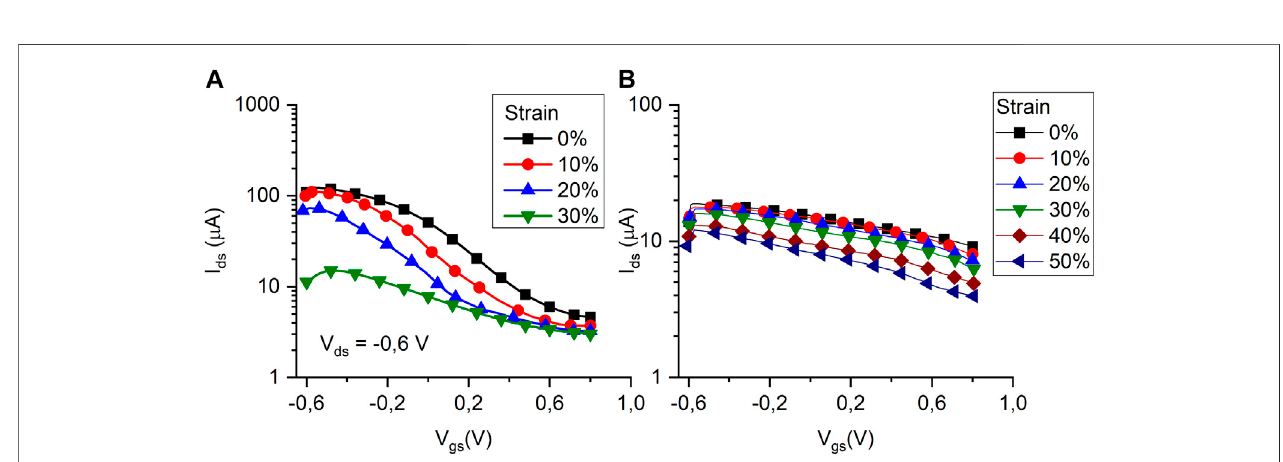
FIGURE8| TransfercurvesofatransistorofMixturesA (A) andB (B) preparedbyelectrospinningunderdifferentstrain:0%( ▬ ),10%( ▬ ),20%( ▬ ),30%( ▬ ),40%( ▬ ) and 50% ( ▬ ), at a V DS of -0.6 V.